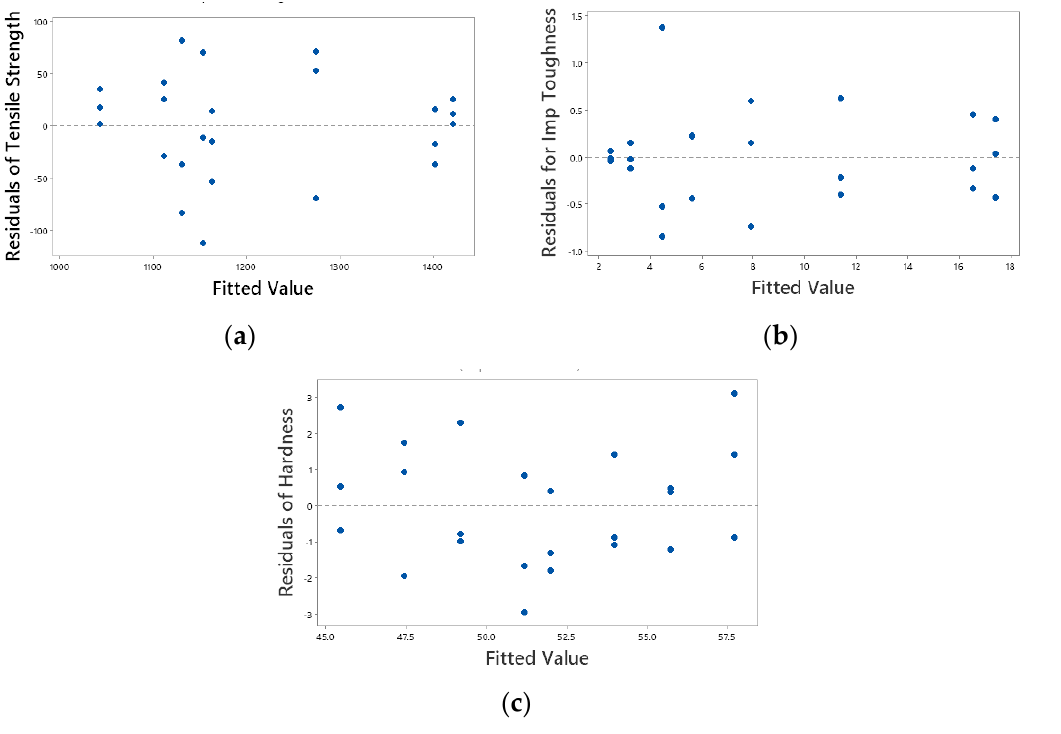
Figure 8. Residuals of properties vs. fitted value for ( a ) tensile strength, ( b ) impact toughness, and ( c ) hardness data. The uneven distribution indicates the constant variance of the data points.